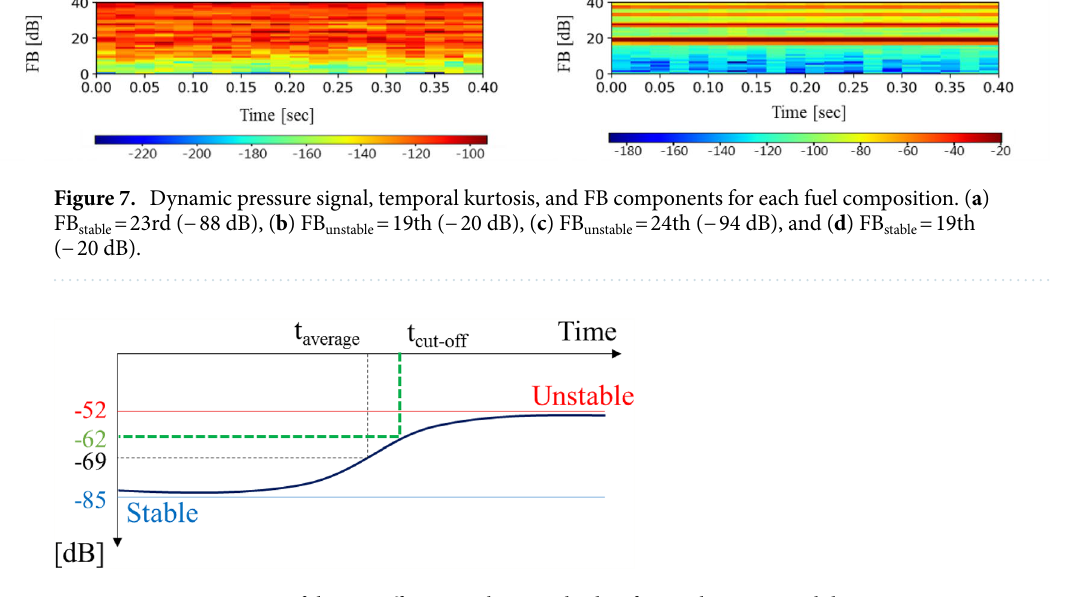
Figure 8. Determination of the cut-off time to obtain early alert for combustion